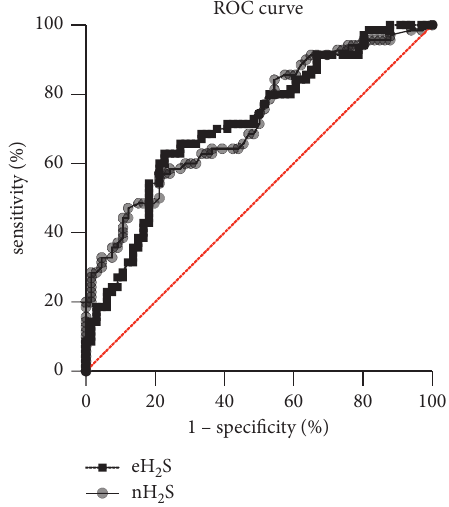
Figure 3: ROC curve of nasal exhaled H H 2 S (eH 2